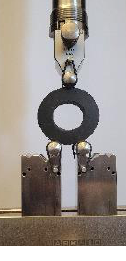
Figure 6. Experimental setups of O-ring multi-contact test for validation.